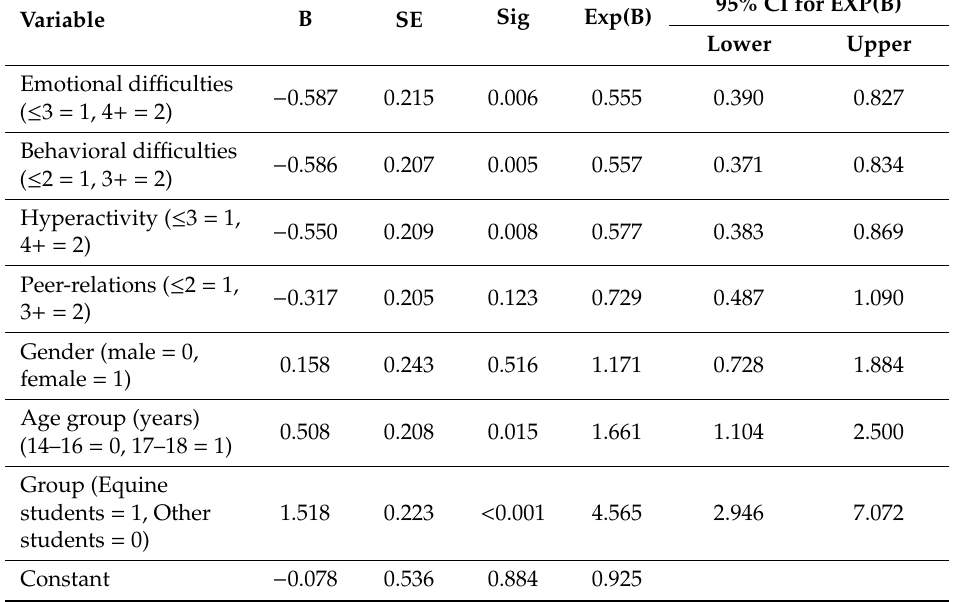
Table 5. Relationship between prosocial behavior (dependent variable) and behavior problems, with a logistic regression model.